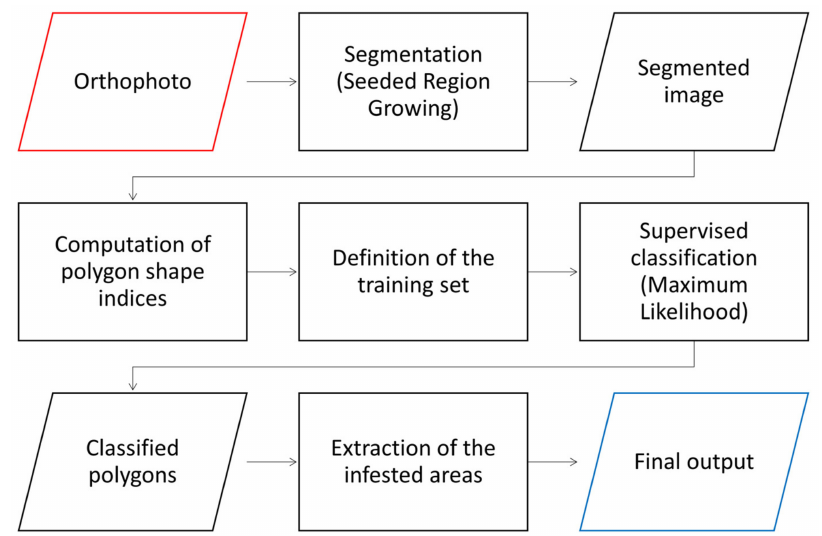
Figure 4. Workflow for the Object-Based Image Analysis weed mapping